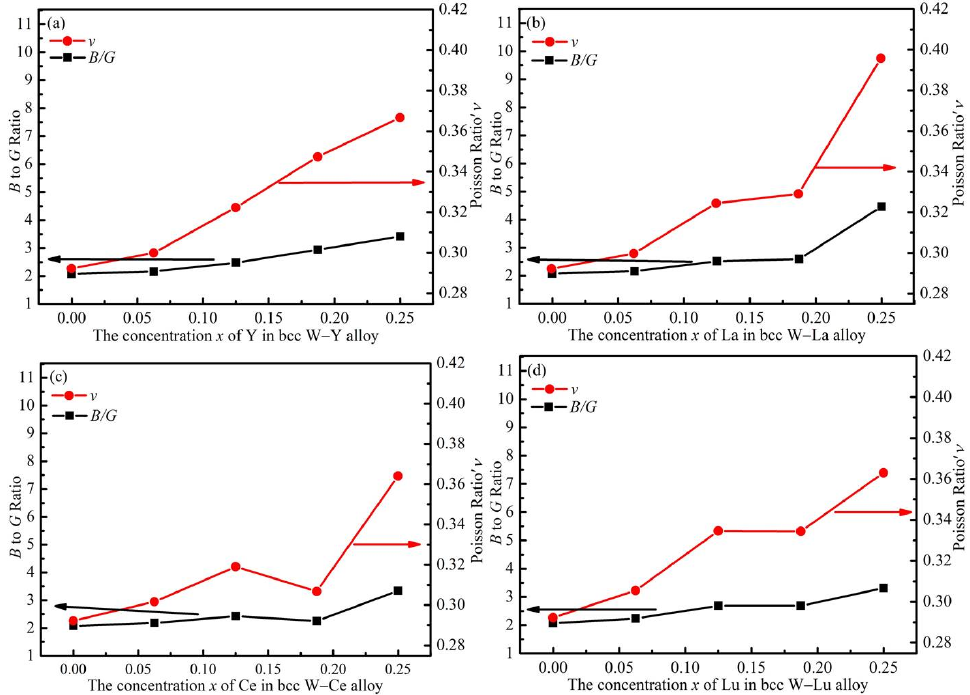
Figure 7. B/G ratio and Poisson’s ratio ( ν ) of W–M binary alloys as functions of M concentration. ( a – d ) represent W–Y, W–La, W–Ce and W–Lu systems, respectively.